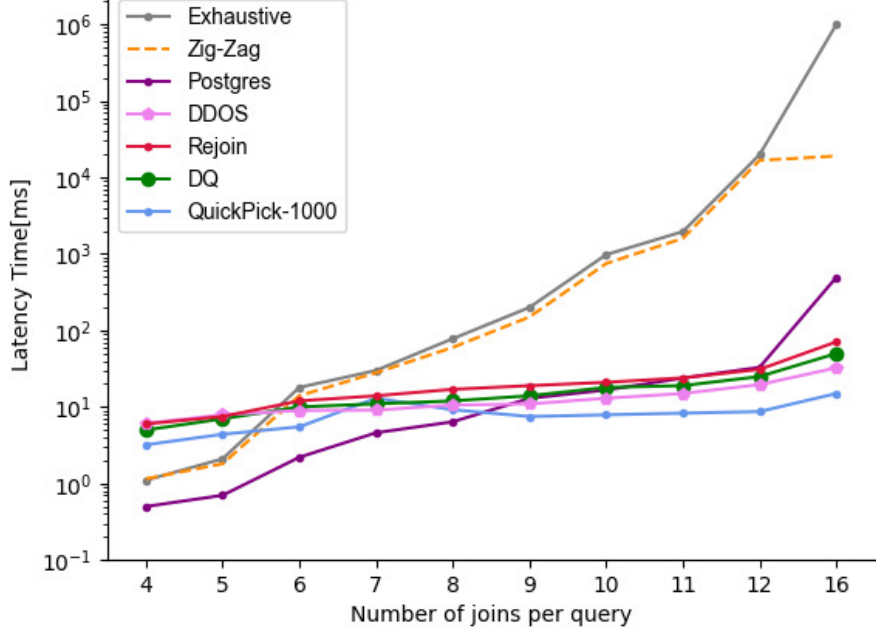
Figure 6. Comparison of the query plan delay times for different optimization